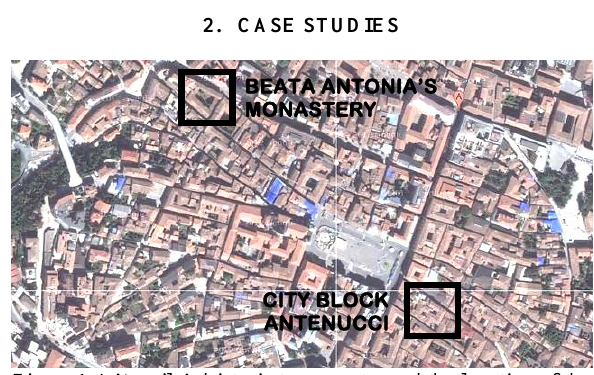
Figure 1. L’Aquila’s historic town centre and the location of the two case studies.